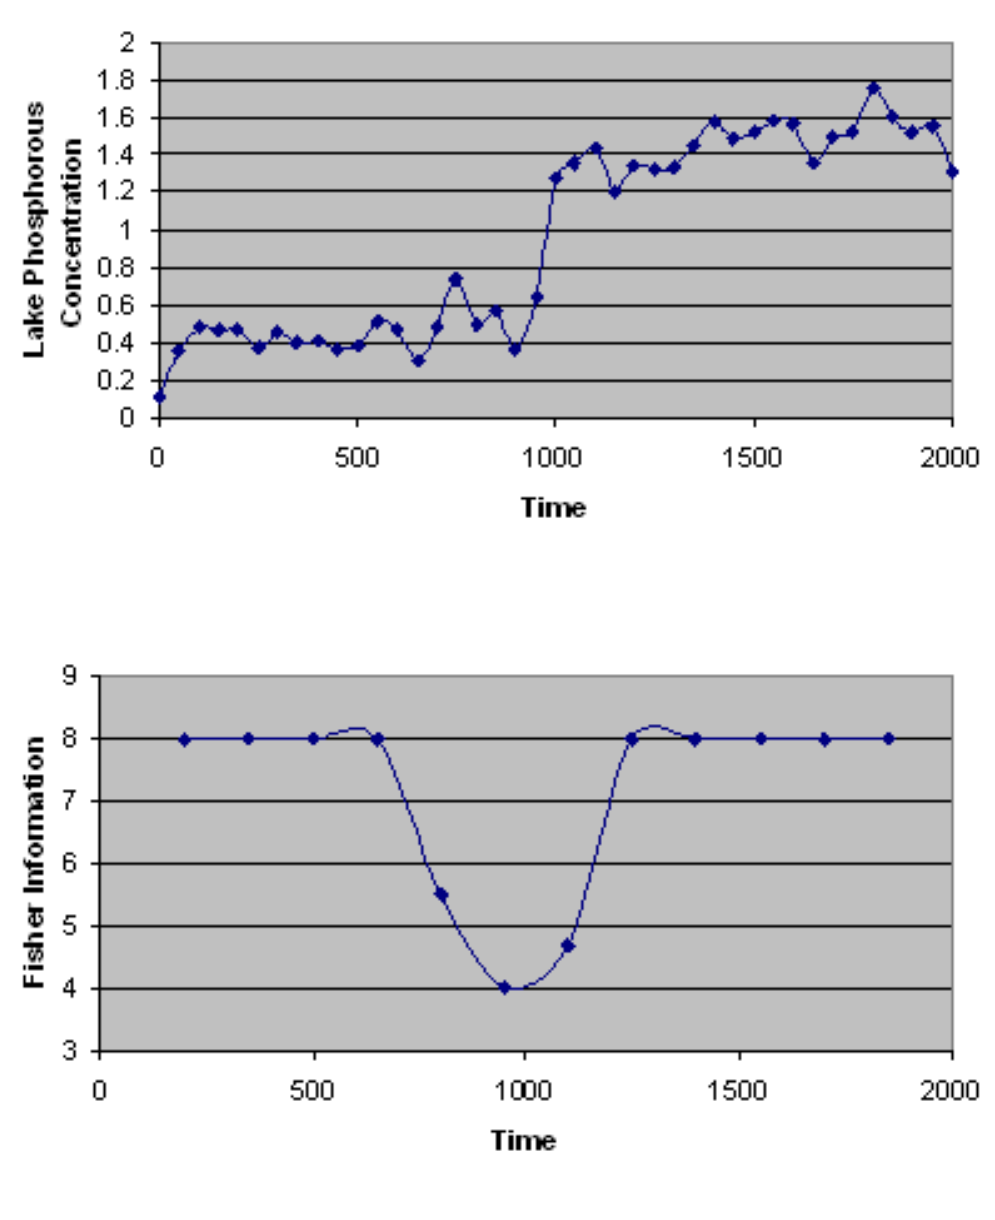
Fig. 2. a) Model solution for lake phosphorous concentration in the case of sparse data and red noise b) Time averaged Fisher